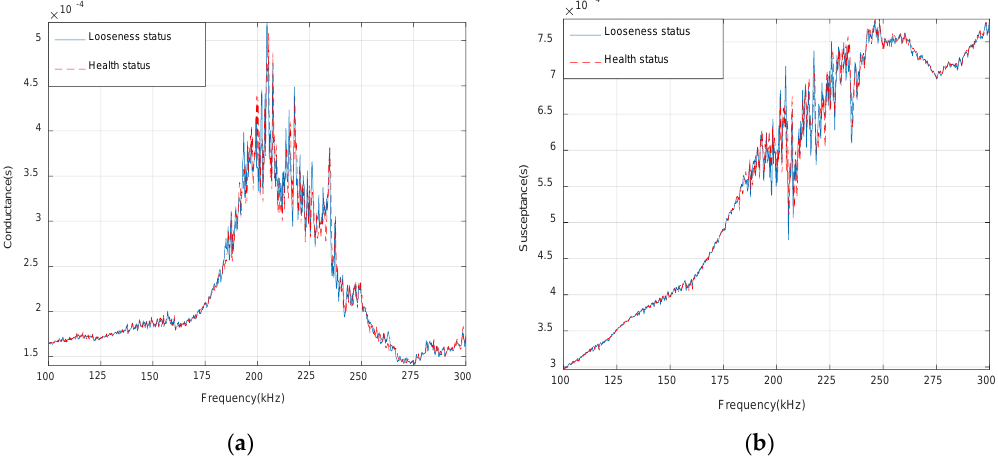
Figure 8. ( a ) Conductance signatures of PZT patch between healthy status and looseness status (100– 300 kHz); ( b ) Susceptance signatures of PZT patch between healthy status and looseness status (100– 300 kHz).